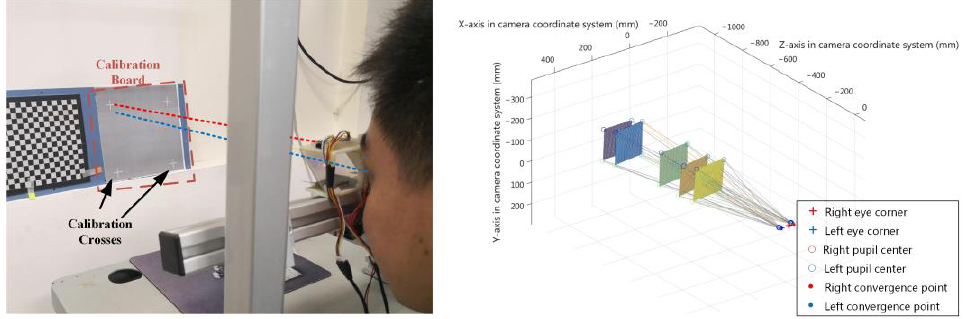
Figure 9. The spatial coordinates of the Point-of-Regard in five calibration steps. The ( left ) graph shows a real picture when using the gaze tracking system. The ( right ) graph shows the system calibration result.